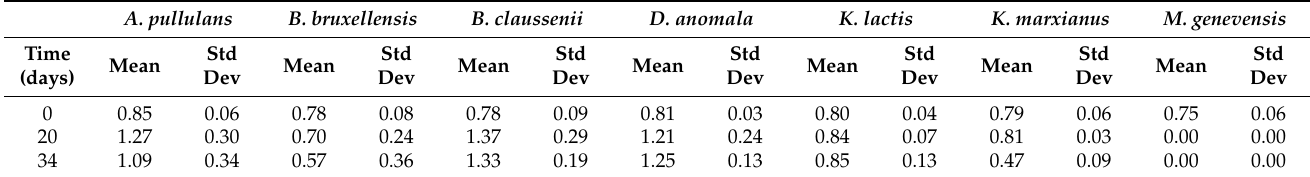
Table 4. Lactic acid concentrations under anaerobic fermentation (g/L).